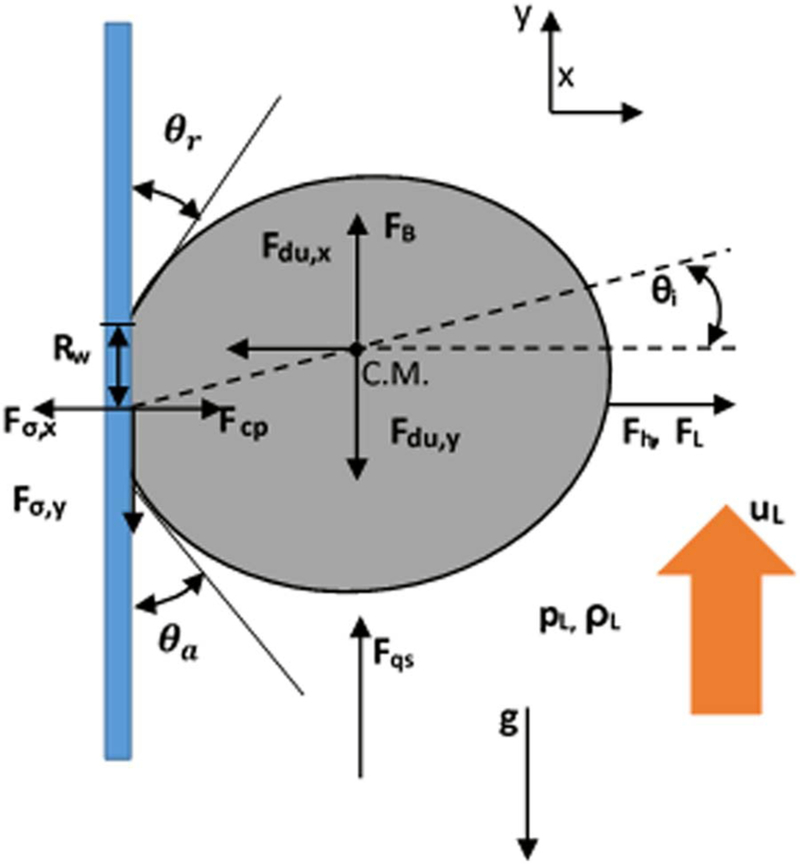
Hydrodynamics forces acting on a bubble at the electrode surface. The expressions of each force are defined in Table I. This figure is reproduced from Taqieddin et al., 2017.2